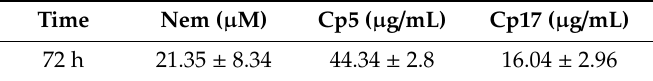
Table 2. IC 50 values of Nem and Cp samples.